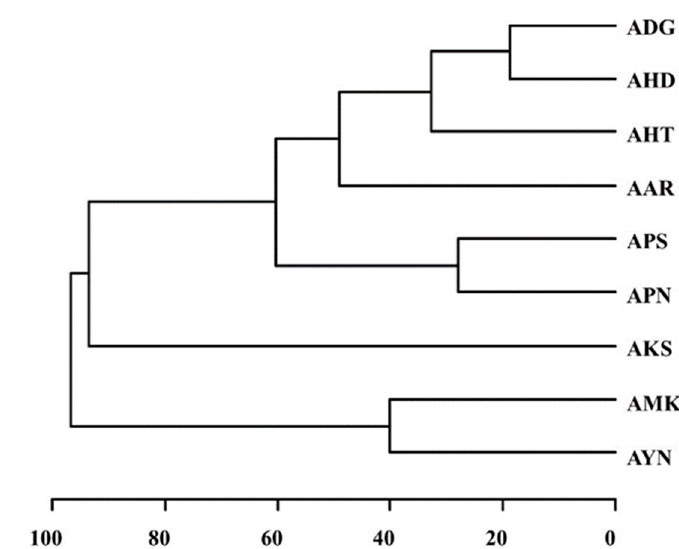
Figure 7. HCA dendrogram depicting the classification of nine Aster species from the PCA of E-nose and GC-MS. ( a ) E-nose dendrogram; ( b ) GC-MS dendrogram.